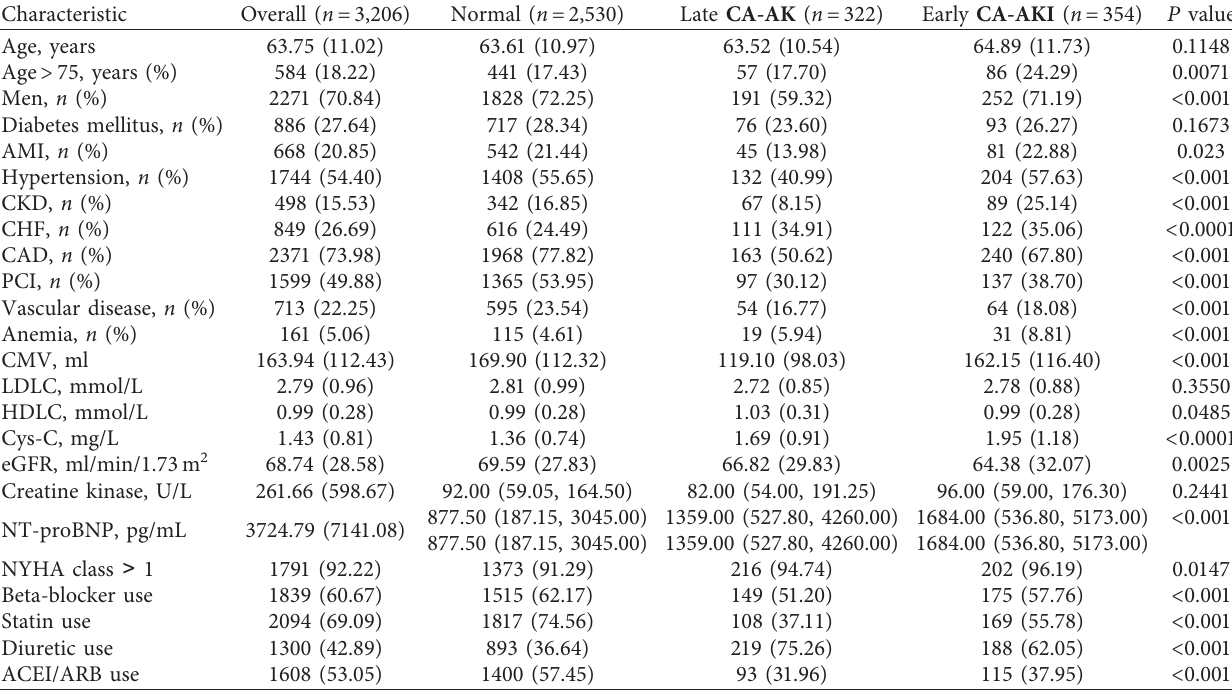
Table 1: Baseline characteristics.